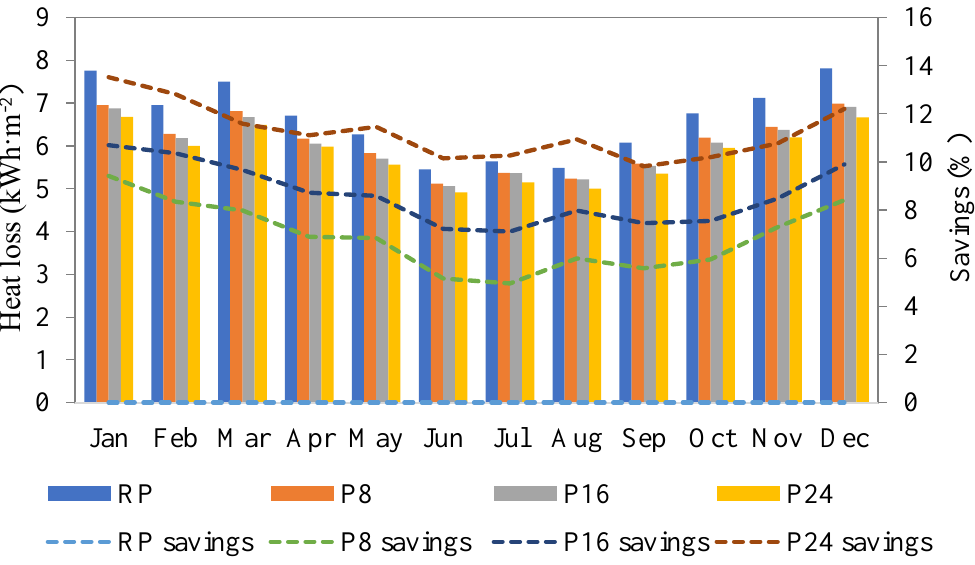
Figure 6. Monthly heat losses and energy savings in Šerák. Table 4. Annual heat energy savings produced by FSPCM